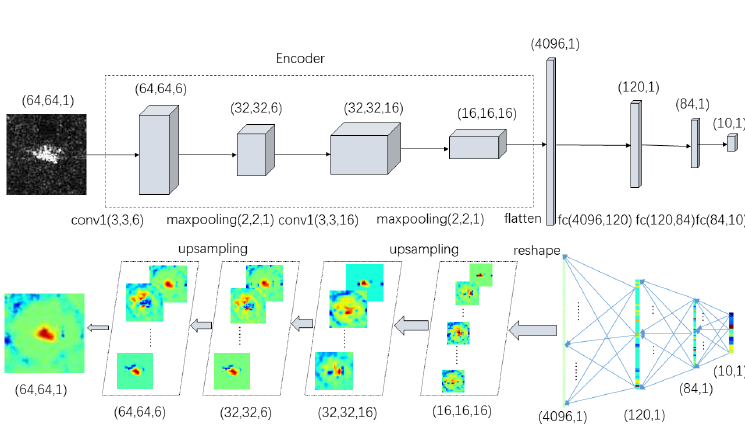
Figure 4. Flowchart of LRP method for